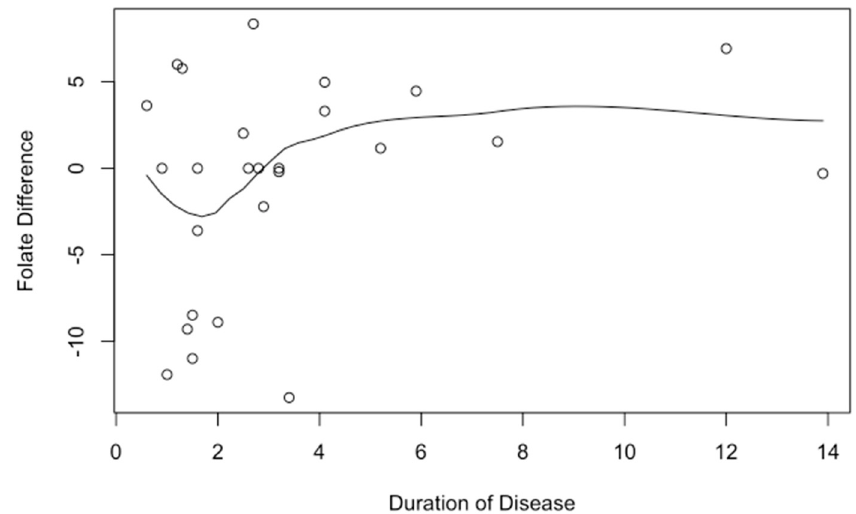
Figure 3. Folate difference pre- to post-study by Duration of Disease.